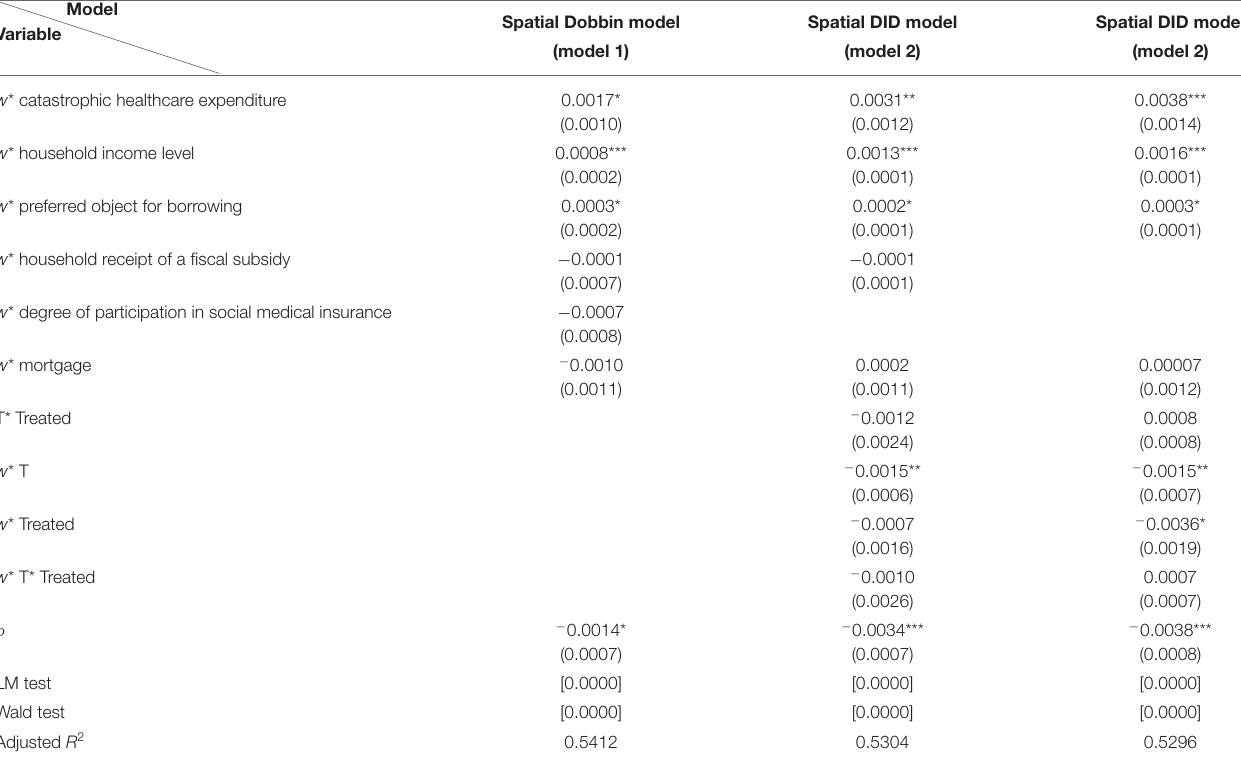
TABLE 2 | Regression